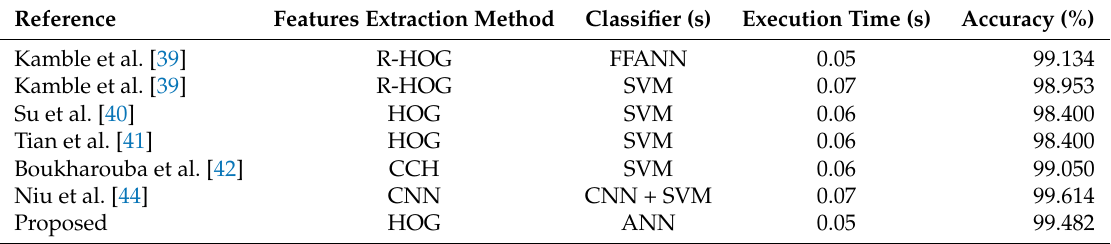
Table 7. Performance comparison on the modified national institute of standards and technology (MNIST)